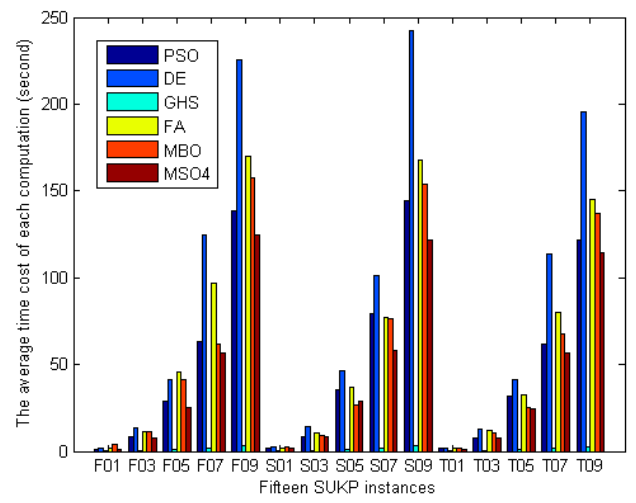
Figure 19. The average time cost of each computation for solving fifteen SUKP instances.